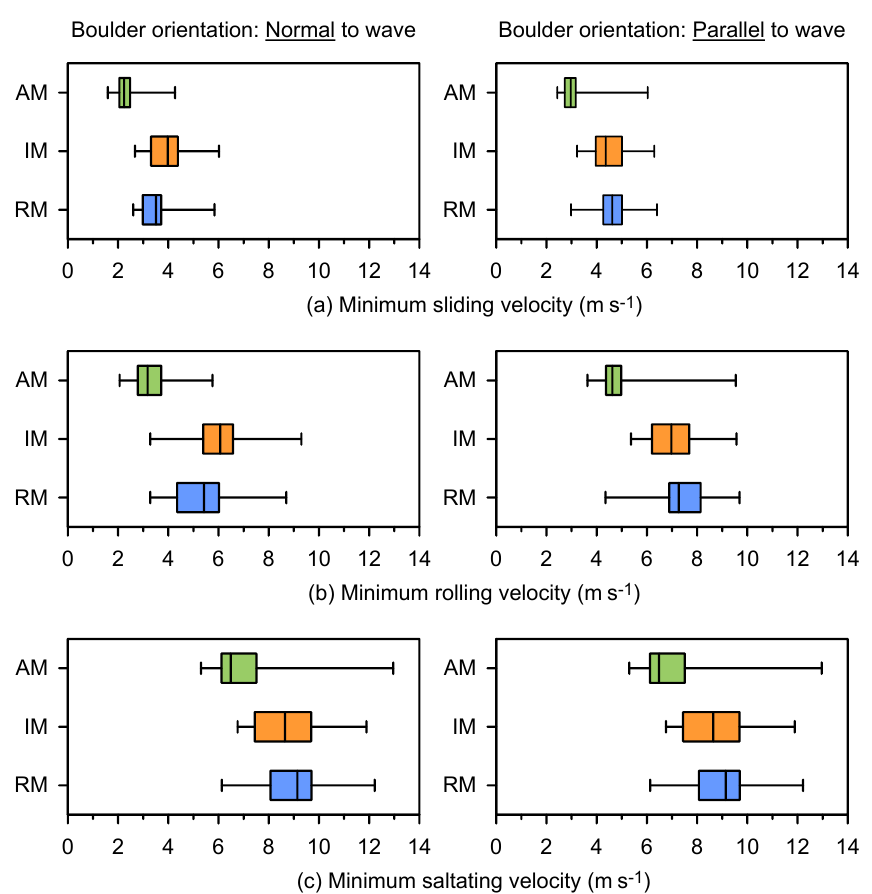
Figure 16. Box plots illustrating the minimum velocities (after [19]) required to emplace boulders at their inland positions by: ( a ) sliding (Equations (1a) and (1b)); ( b ) rolling (Equations (2a) and (2b)), and; ( c ) lifting / saltating (Equation (3)). The boulders of interest are separated into recent movers (RM), indeterminate movers (IM) and ancient movers (AM), with movement di ff erentiated between flow-normal (left) and flow-parallel (right) orientations of the